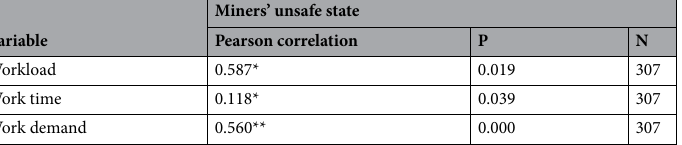
Table 6. Correlation analysis results of workload and its dimensions and miners’ unsafe state. p represents the significance value. *represents a significant level at p < 0.05. **represents a significant level at p < 0.01. N represents the sample